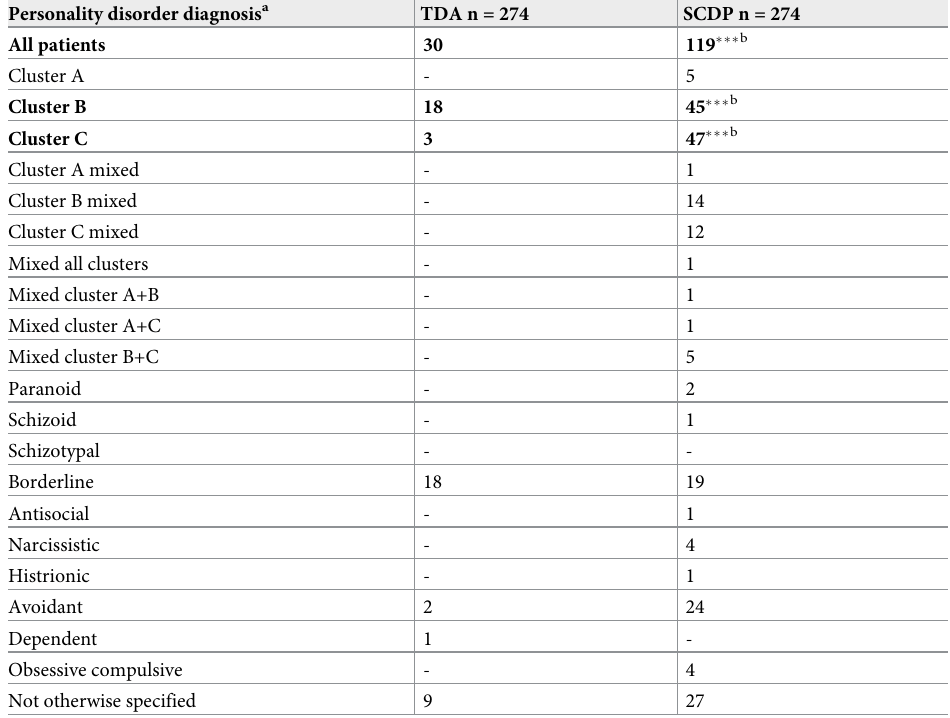
Table 4. Number of patients with personality disorders for traditional diagnostic assessment (TDA) according to medical records and structured and comprehensive diagnostic procedure (SCDP) according to the study protocol. Personality disorder diagnosis a